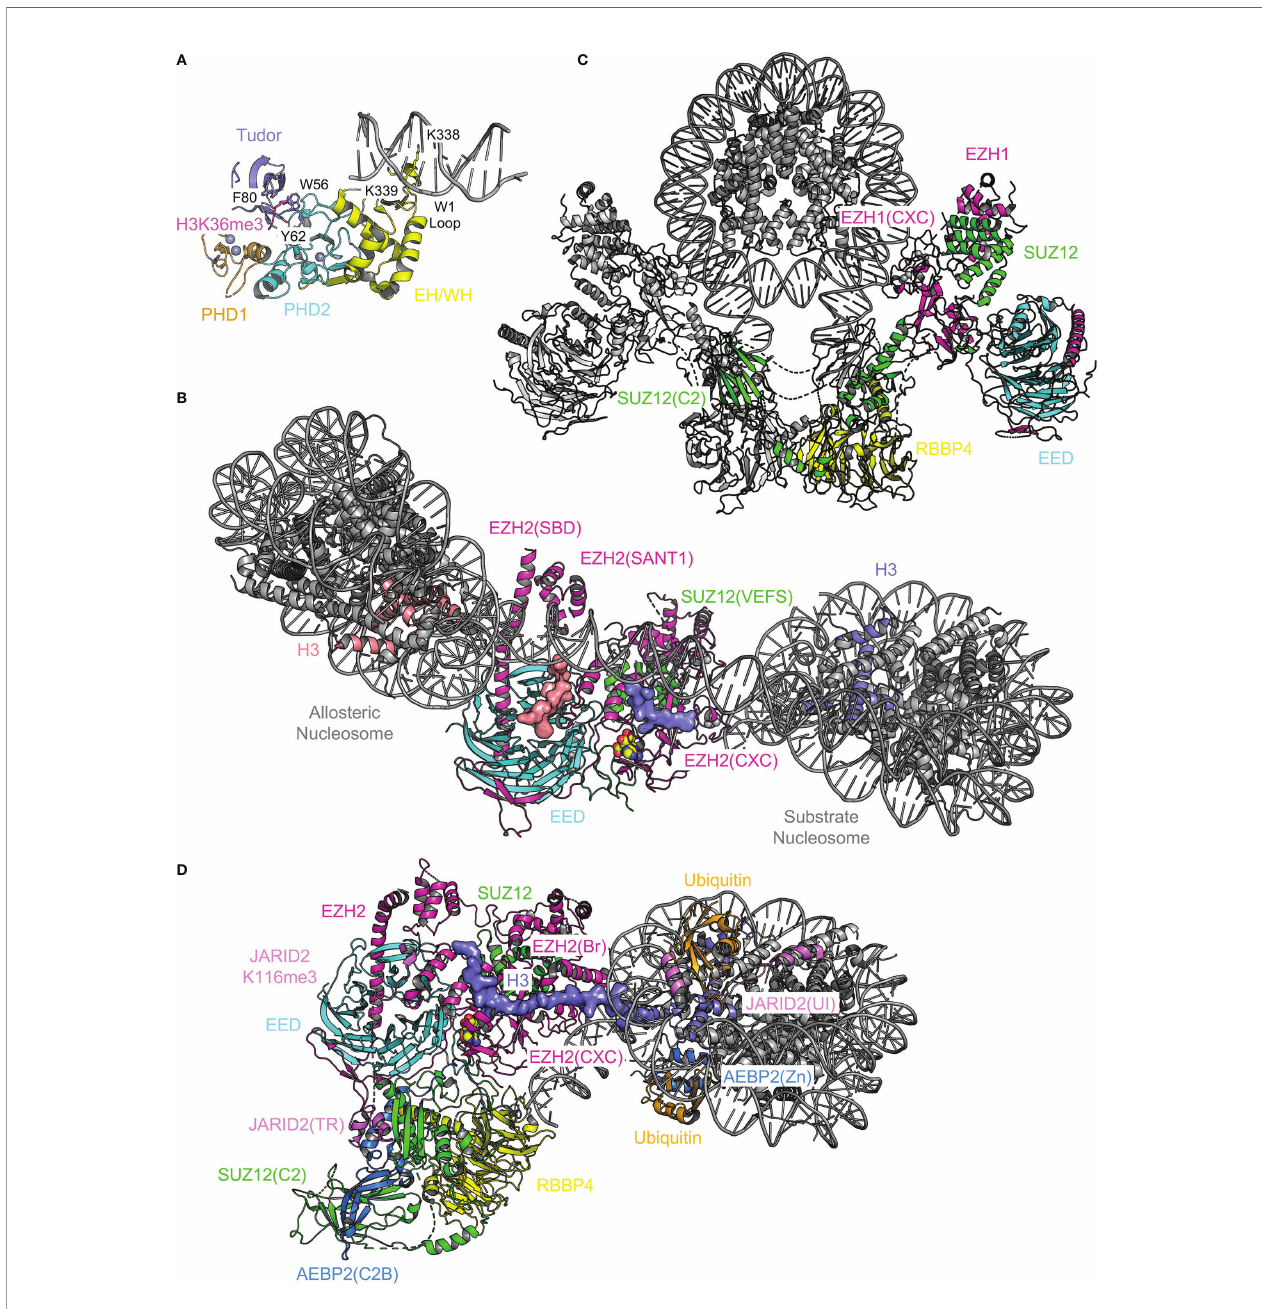
FIGURE 7 | Structural analysis of chromatin binding by PRC2. Structural elements of PRC2 responsible for chromatin binding are analyzed. (A) Structure of MTF2 (Tudor – PHD1 – PHD2 – EH/WH) bound to CpG DNA and H3K36me3 (PDB 5XFR). Aromatic cage residues of the Tudor domain are shown as sticks and labeled. Two lysine residues of the W1 loop of the EH/WH domain inserted into the DNA major groove are shown as sticks and labeled. (B) Structure of PRC2 bound to a dinucleosome (PDB not available). Only the catalytic module is visible. Substrate and allosteric nucleosomes are labeled. Two major docking sites for nucleosomes, EZH2(SBD) – EZH2(SANT1) and EZH2(CXC), are indicated. Histone H3 tail bound to the active site is shown as surface representation. (C) Structure of dimeric EZH1- containing PRC2 bound to a mononucleosome (PDBs 7KTQ, 7KSR, and 7KTP). Subunits of one of the two PRC2 protomers are color-coded. (D) Structure of AEBP2 and JARID2-containing PRC2.2 bound to a mononucleosome with H2AK119ub (PDB 6WKR). Functional domains are color-coded and labeled. The entire histone H3 tail is ordered and shown as surface